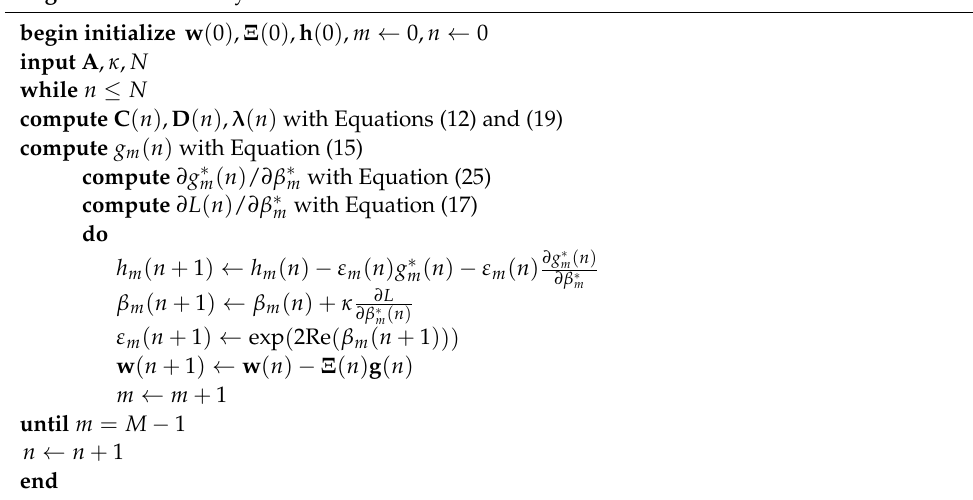
Algorithm 1 Summary of the IDBD-based